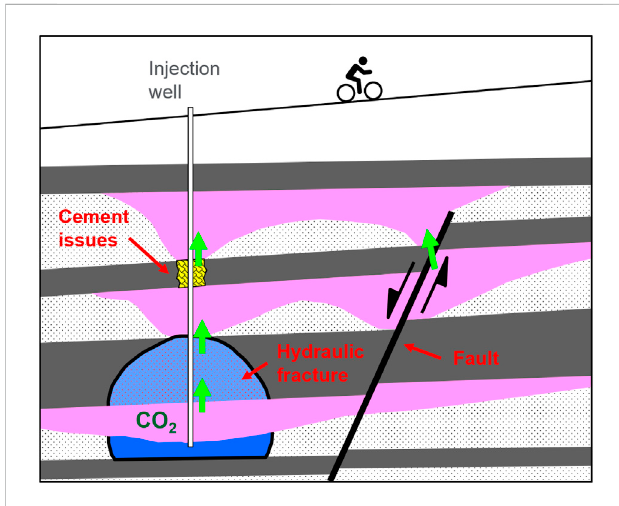
FIGURE 10 Schematic illustration of possible CO 2 leakage pathways. Potential CO 2 migration indicated with green arrows. Modi fi ed from original publication (Hawkes et al., 2005).